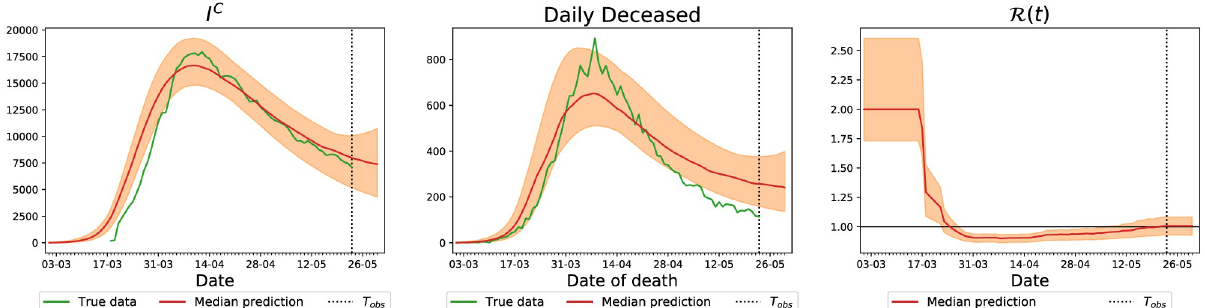
Fig 6. Comparison of predictions of our model with the real number of hospitalized people with COVID-19 and total daily deaths (green) on 23rd May for England. The solid red line denotes the median prediction, filled spaces denote the 99% credible interval and the vertical dashed line denotes the observation horizon. The different columns represent number of people in hospital, I C (left), daily deceased (middle) and value of R ð t Þ (right).